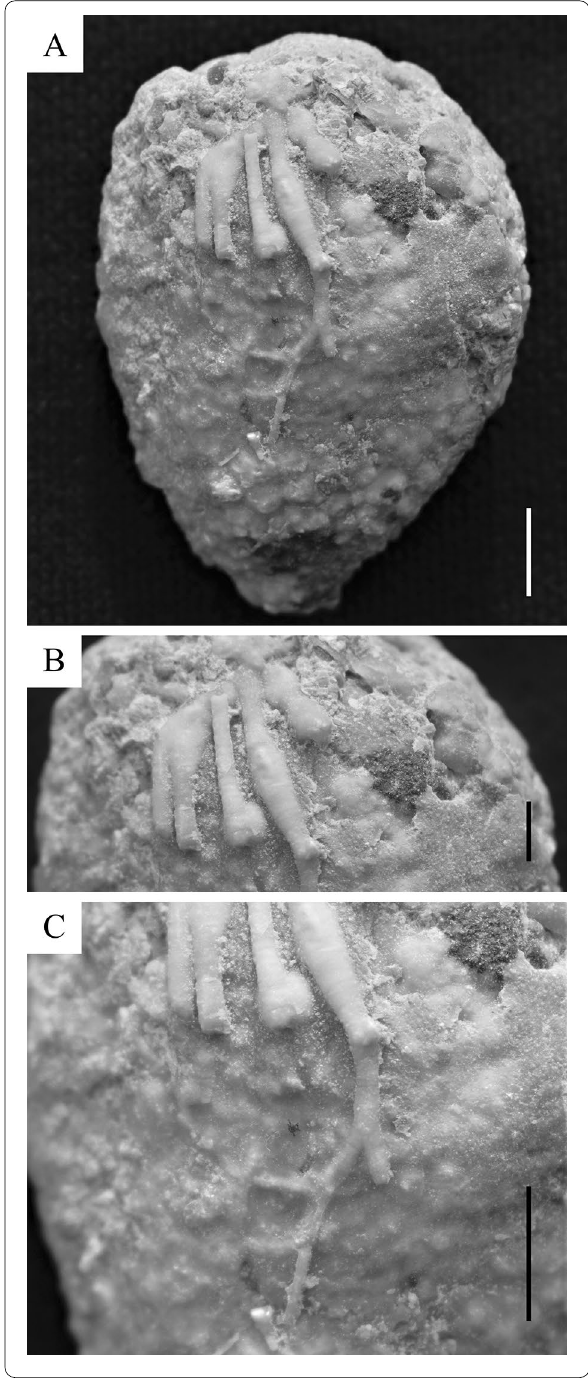
Fig. 1 Theca of the holocystitid diploporitan Holocystites scutellatus from the middle Silurian Massie Formation of southeastern Indiana, USA (CMC IP 88496), encrusted by a dendritic radicular attachment structure belonging to the camerate crinoid Eucalyptocrinites . A View of the lateral surface of the diploporitan theca with the encrusting crinoid attachment structure near the oral pole (at the top of the specimen in this image). Note that the radices extending down along the surface of the theca are relatively long. Scale bar 10 mm. = B Close-up of the encrusting attachment structure, showing the well-developed radices extending from the oral region toward the aboral region and the essentially invisible radices extending toward the oral pole. Scale bar 2 mm. C View of the longest radice, = displaying dichotomous branching and tapering. This radice extends over most of the lateral surface of the theca. Scale bar 5 mm